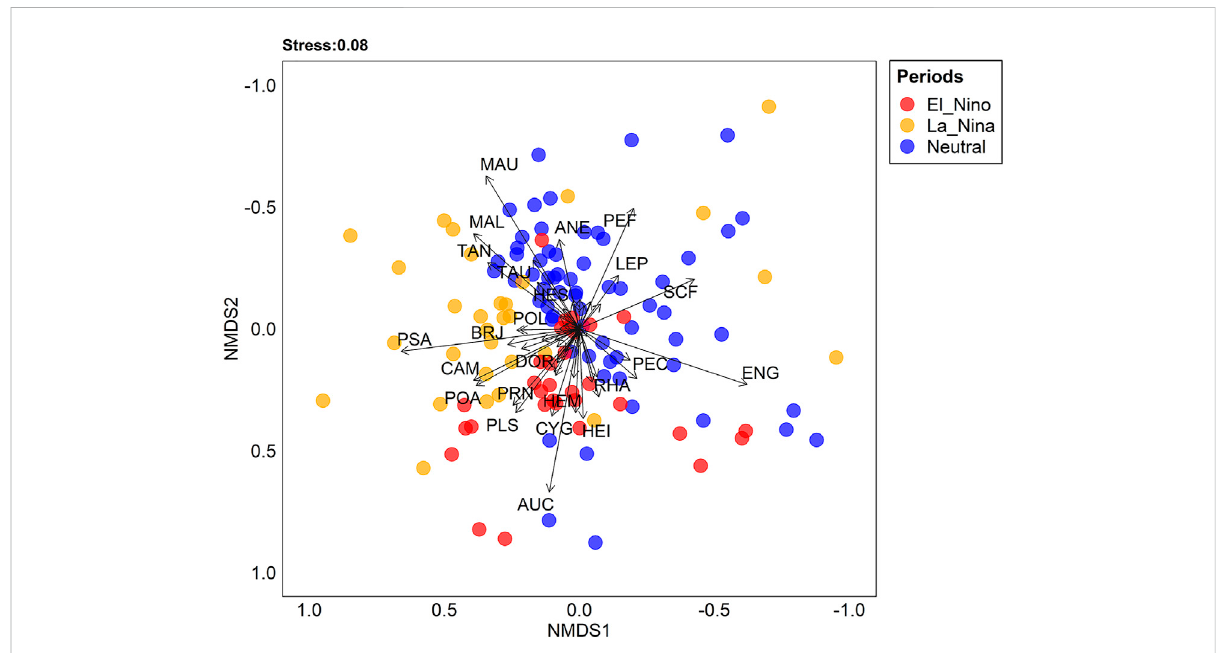
FIGURE 3 Non-metric multidimensional scaling ordinations (nMDS) visualizing period effects on fi sh assemblage composition. MAL — Mylossoma